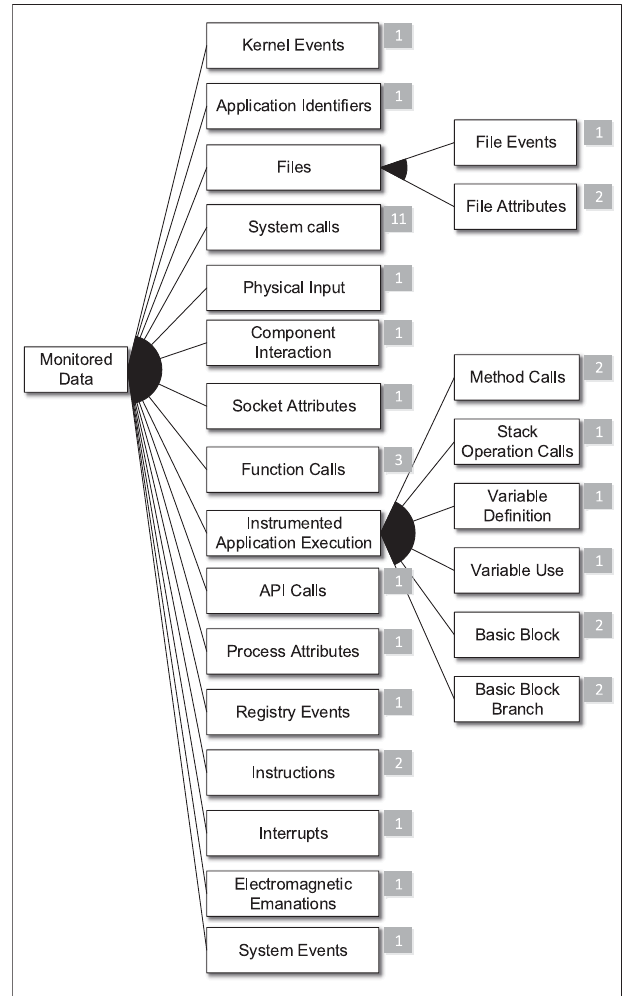
FIGURE 9 | The monitored data